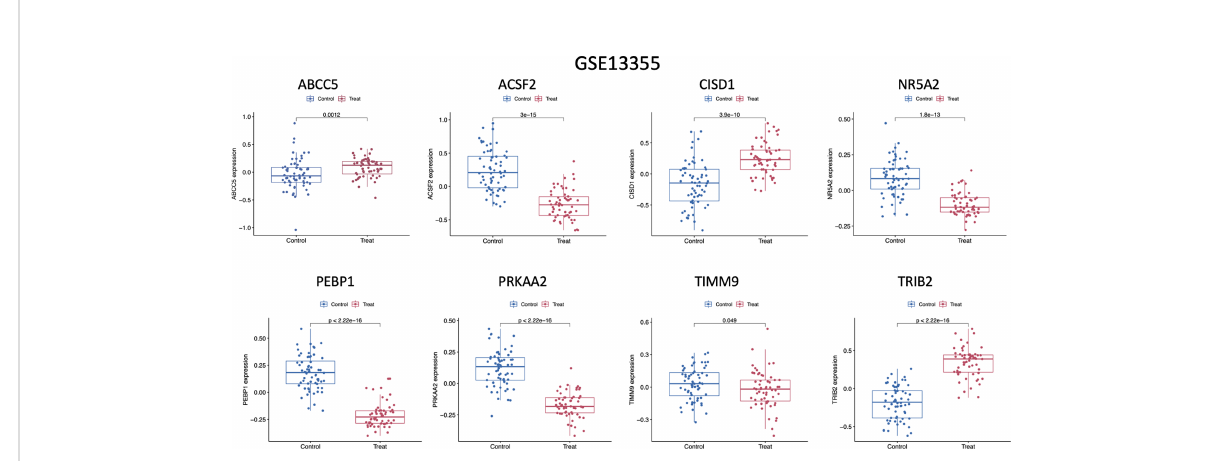
FIGURE 5 Expression of the marker gene in the validation set. The expression of marker genes in the GSE13355